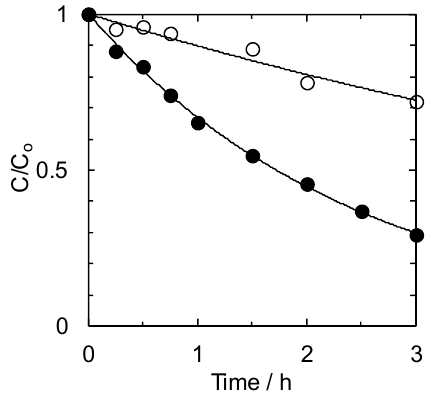
Figure 7. Phenol decomposition by the water-purification system. open circles: UV-C/TMiP reactor; solid circles: UV-C/TMiP/O reactor (10 mg/L). Reproduced with permission 3